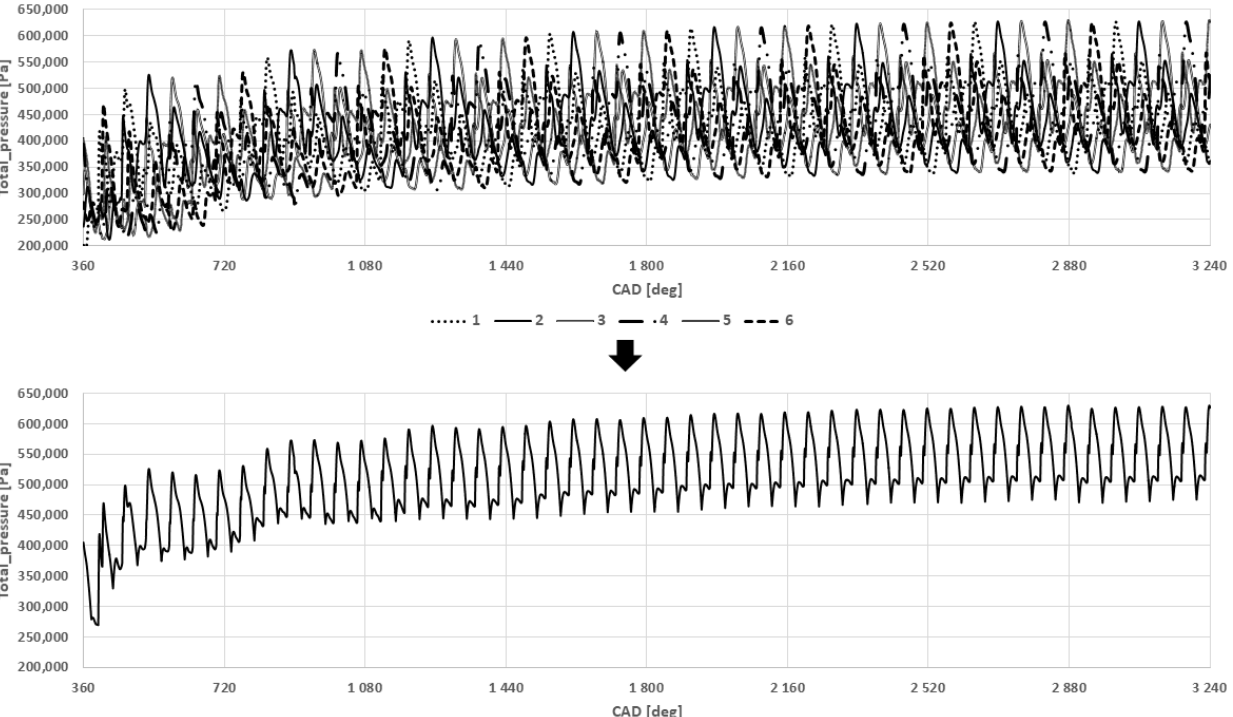
Figure 17. The superposition of the pressure plots at the inlet to the first-stage rotor for nine revolu- tions of the crankshaft.